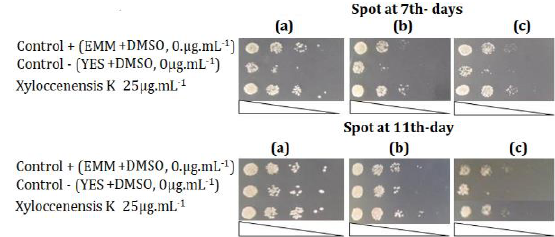
Figure 6. Effect of Xyloccensins K on the viability of S.pombe cells against oxidative stress.